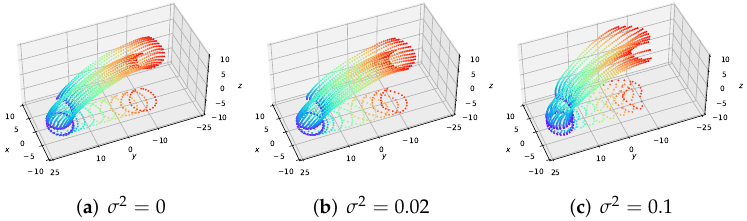
Figure 5. Comparison of the executed trajectories for the formation flight of large-scale UAVs about